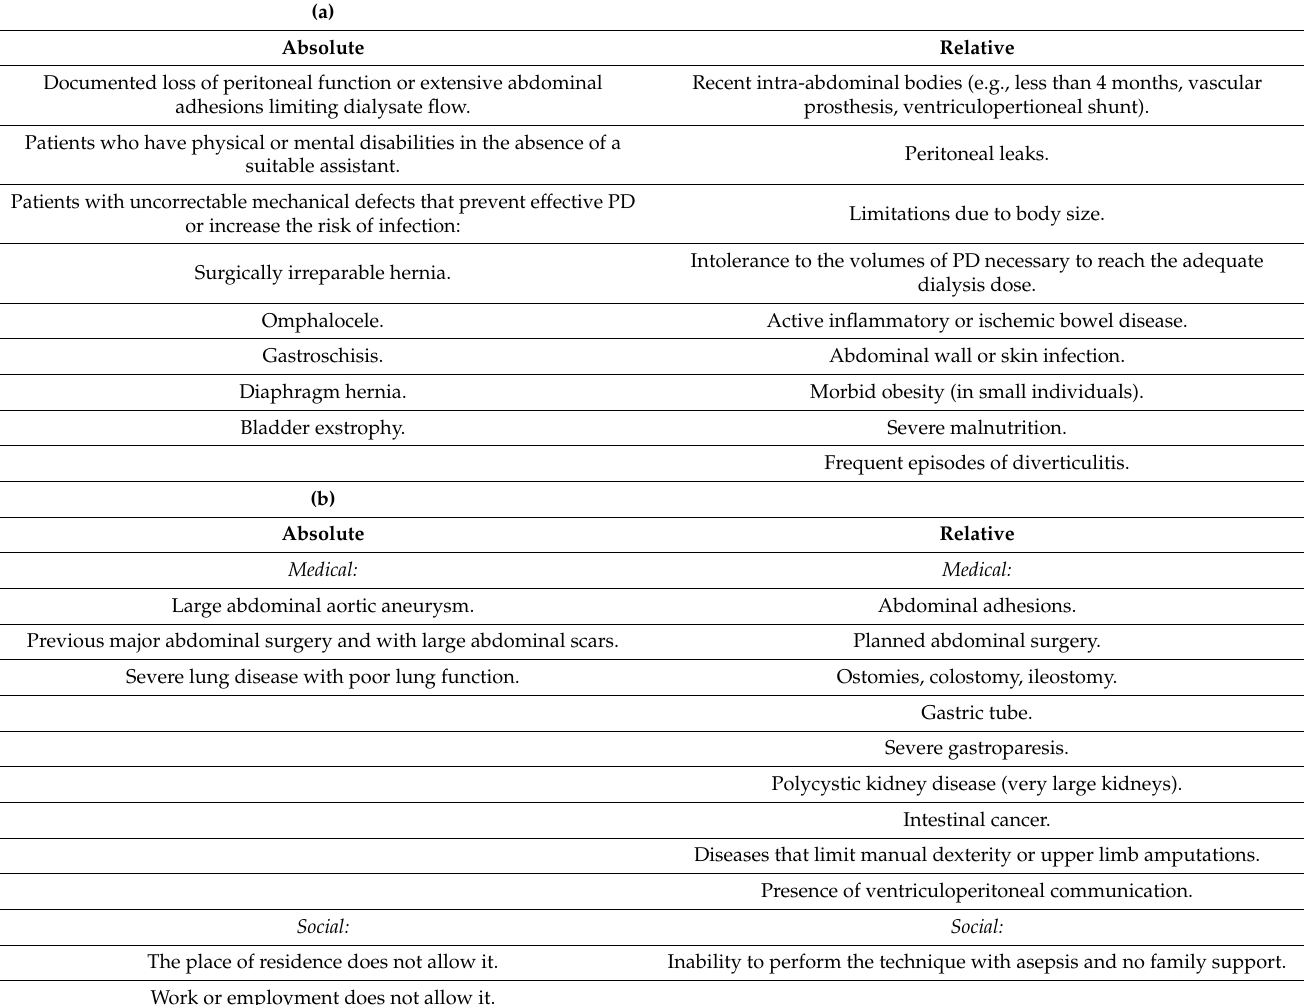
Table 3. Contraindications of PD: (a) according to the clinical practice recommendations of the NKF-KDOQI (Golper TA, Am J Kidney Disease 2001); (b) other contraindications mentioned in the literature. (a) Absolute